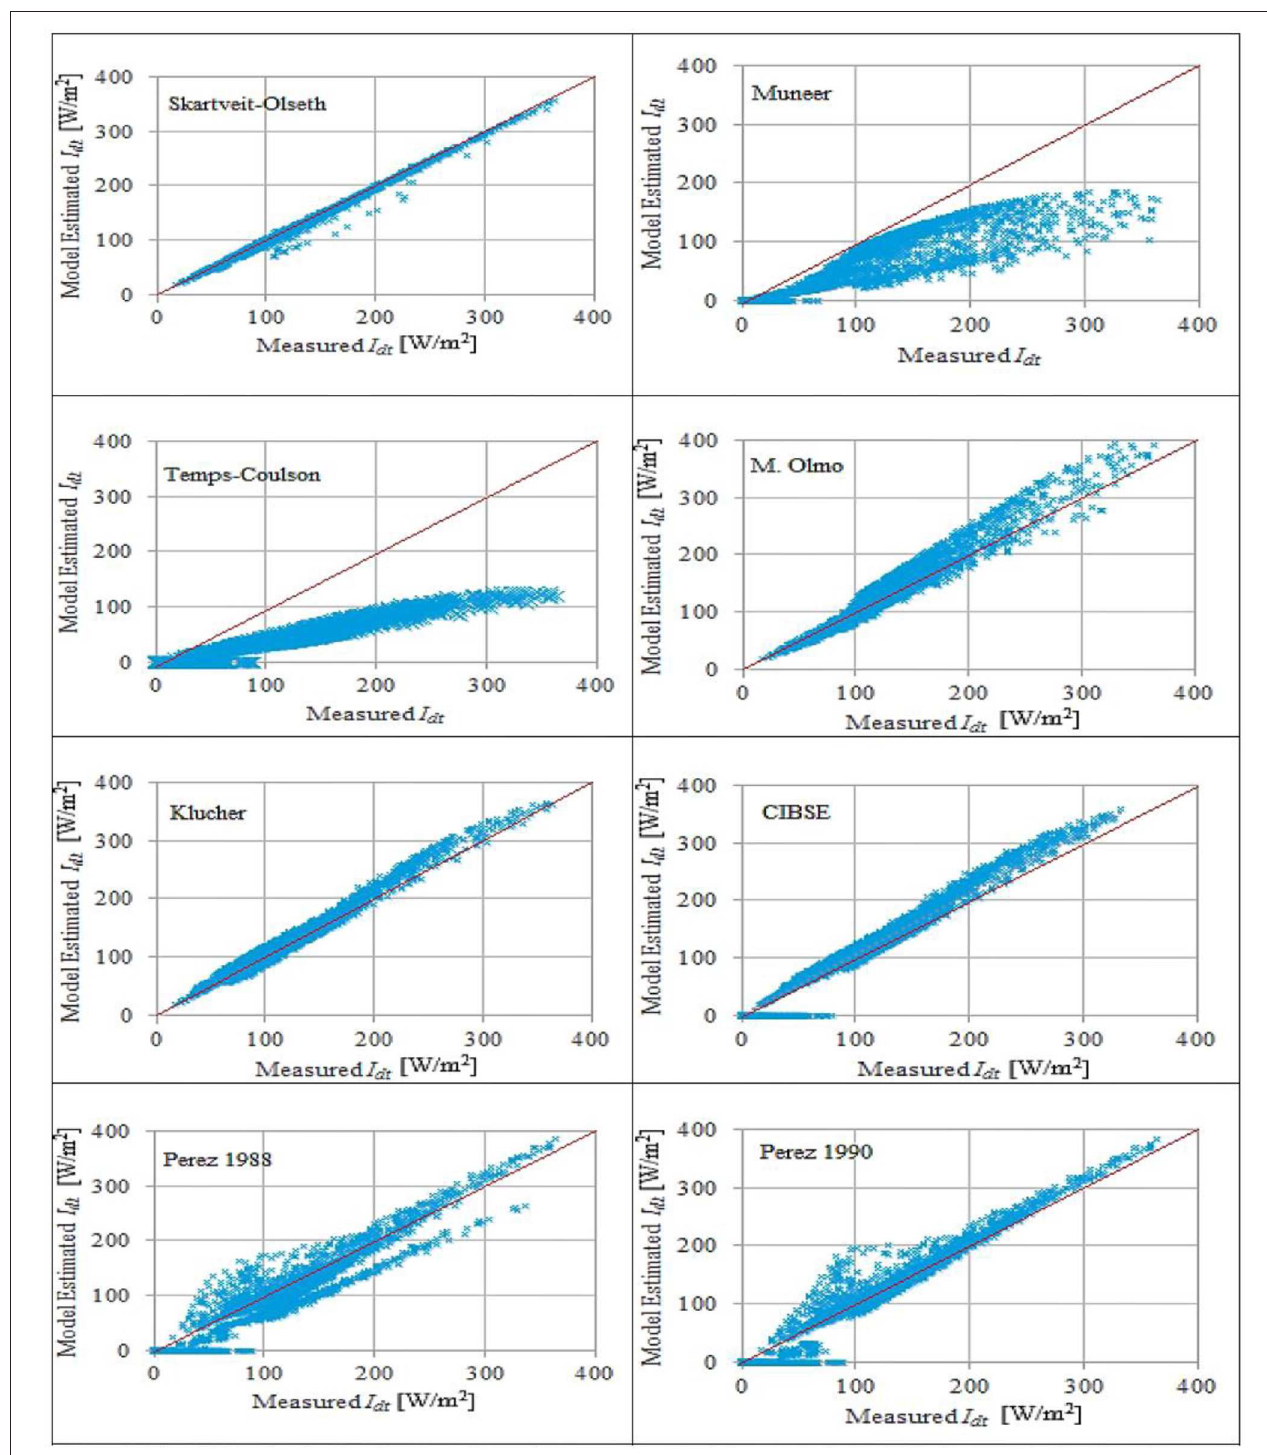
FIGURE 3 | Sky-diffused solar irradiance estimation vs. measures for south-facing 30 ◦ tilt angle inclined surface in Herbon city for 24 models during all sky conditions (8,700 points depicted in the graph) (blue dot), y = x relation (red line).